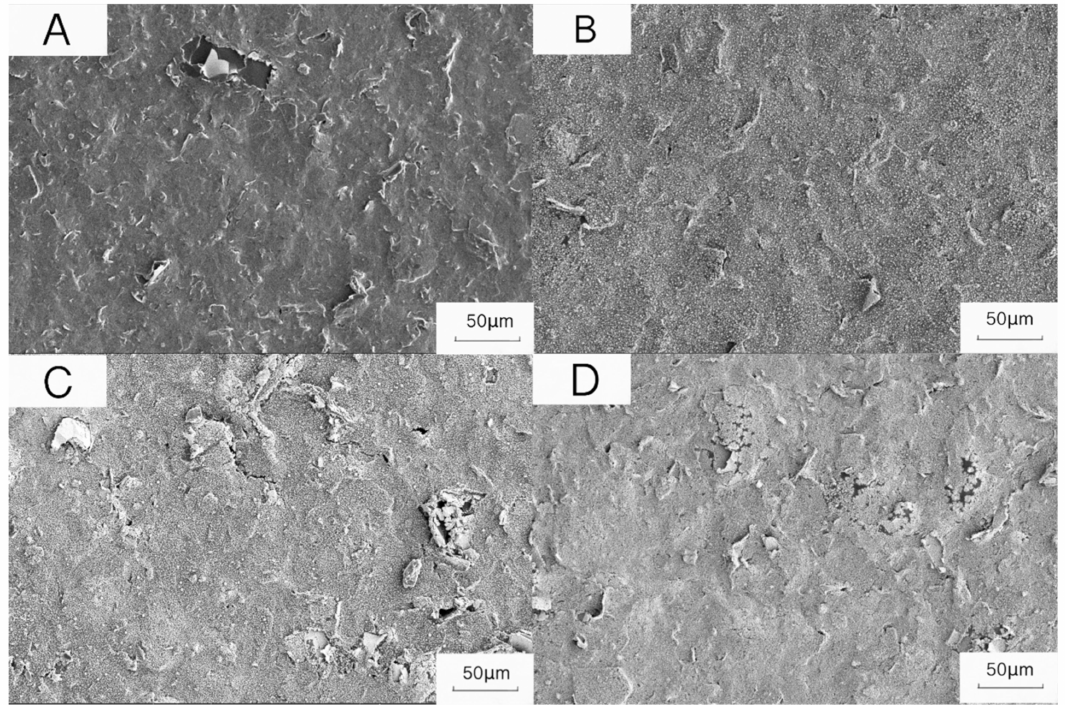
Figure 3. Scanning electron micrograph of the sensor. ( A ) Bare electrode CV (bare SPCE), ( B ) electrode after deposition of HAuCl 4 solution, ( C ) electrode after polymerizing cyromazine molecular polymer, ( D ) electrode after